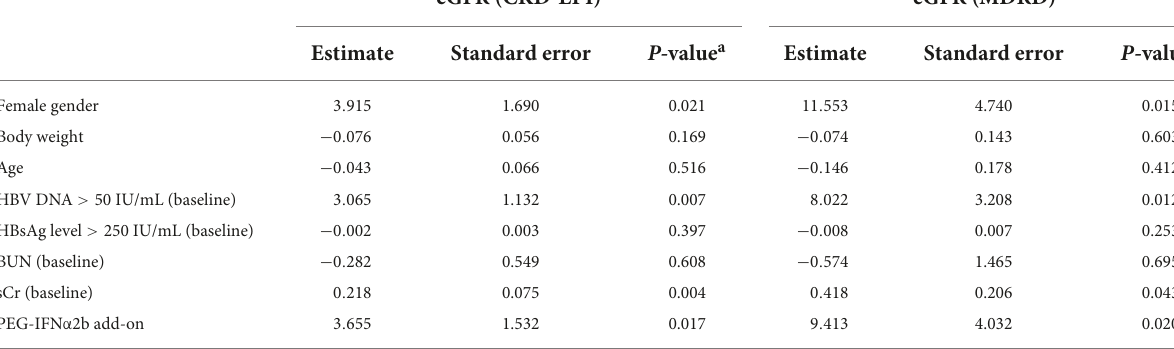
TABLE 2 Predictors for eGFR changes at 24 weeks of therapy.